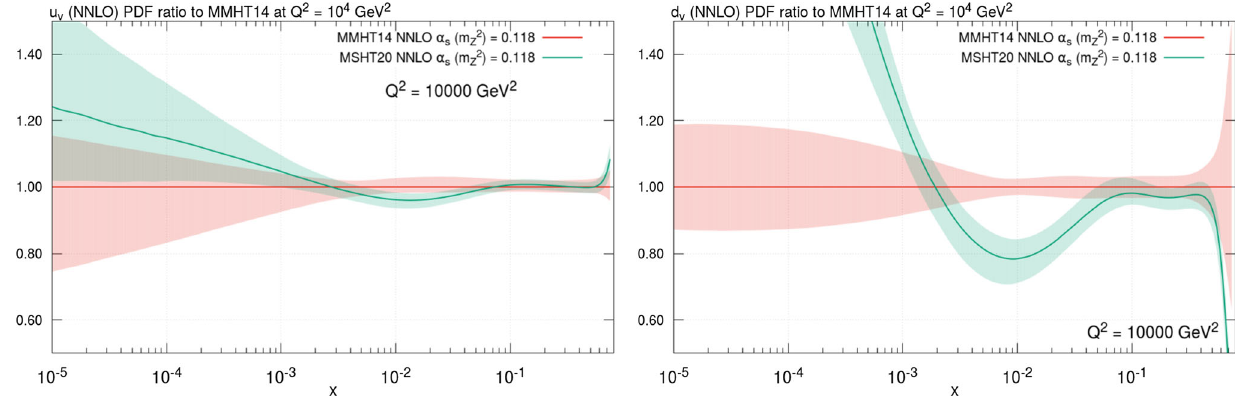
Fig. 22 Ratio of (left) Up valence and (right) Down valence PDFs to MMHT14 at NNLO and Q 2 = 10 4 GeV 2